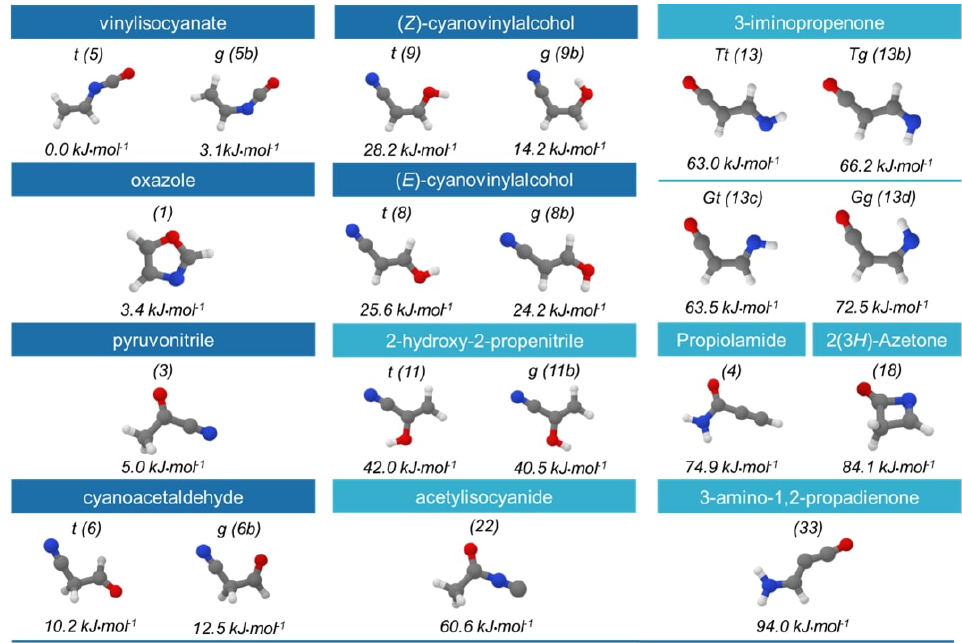
Figure 2. Schematic representation of the 20 isomers considered in the second step of our procedure (energy refinement). The relative energies are at the CBS + CV + hZPE level and computed on top of the revDSD/junTZ geometries. The 10 most stable isomers are reported in blue, while light blue is employed for the remaining